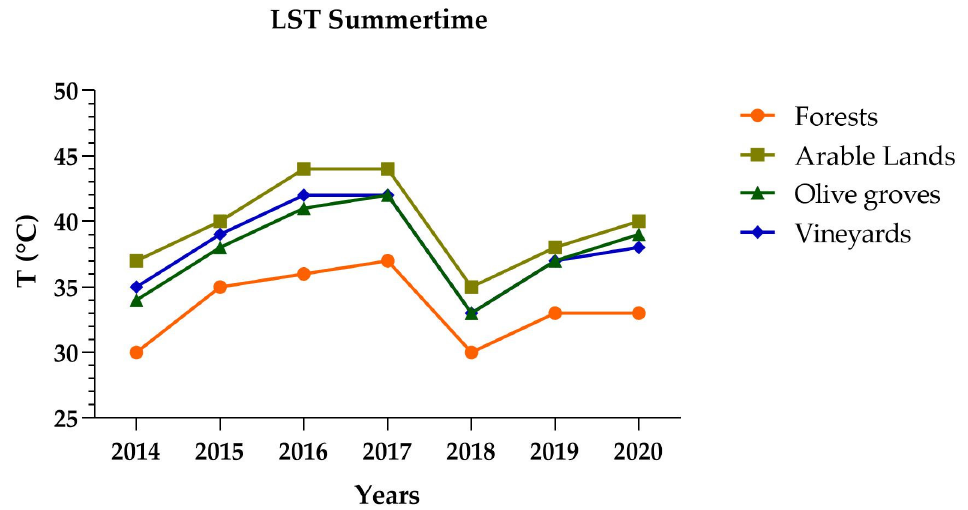
Figure 4. Average LST temperature for each type of land cover from 21 July to 11 August. As reported, the LST value is influenced by climate conditions: the low value of LST for 2014 and 2018 corresponds to a high value of cumulative precipitation and low air temperature, while the highest value for the year 2017 corresponds to the absence of pre- cipitation and the highest air temperature (Figure 5). The Fisher test showed that the av- erage LST for different land cover types for different years belonged to distributions hav- ing a different variance (Table 2), while the average values of the Student’s t test were statistically different. Indeed, in the tests the values were higher than the references tabu- lated to determine the significance. Table 2. Fisher test and Student test to analyse the statistical differences among the land covers reported in the Figure 4. Years α = 5% Ftab = 1.01 Ttab = 1.65 Ftab = 1.01 Ttab = 1.65 Ftab = 1.01 Ttab = 1.65 Ftab = 1.01 Ttab = 1.65 Ftab = 1.01 Ttab = 1.65 Ftab = 1.01 Ttab = 1.65 F-Test